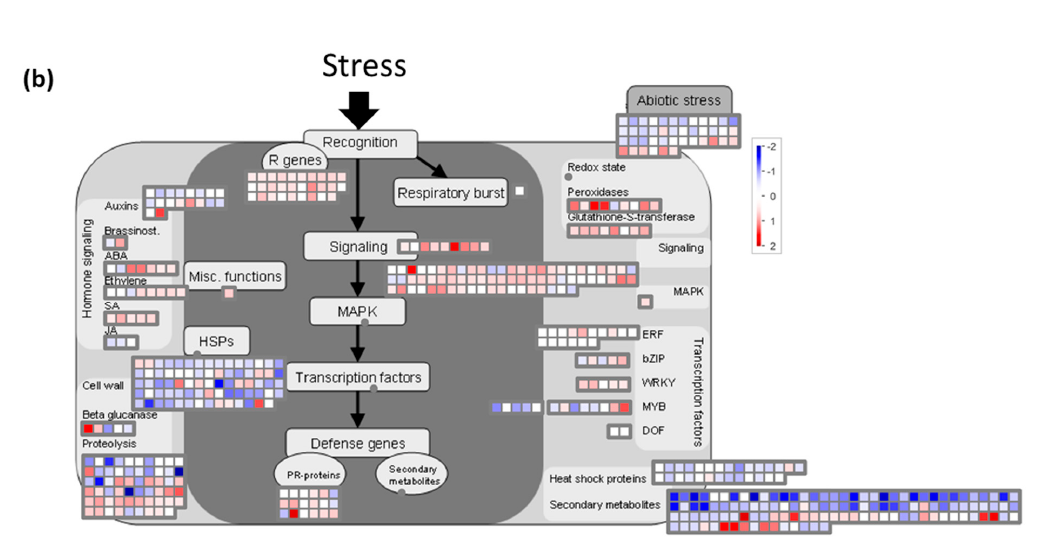
Int. J. Mol. Sci. 2019 , 20 , 1130 Figure 4. Mapman visualization of the stress pathway modulation at ( a ) 8 h and ( b ) 2 h PS.